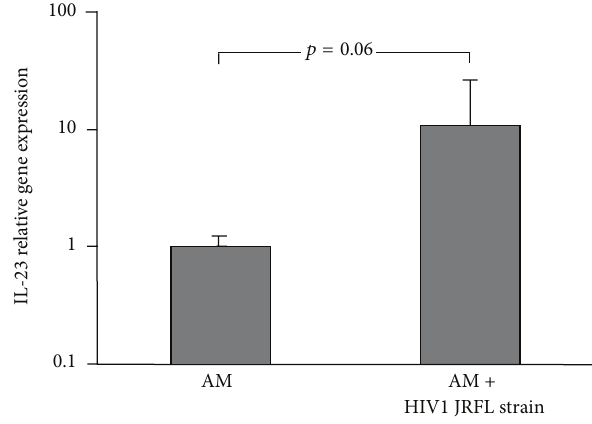
Figure 3: Effect of HIV1 infection in vitro on AM-IL-23 upregu- lation. AM isolated from HIV1 − individuals ( 𝑛 = 5 ) were infected with HIV1 JRFL 10 3 TCID/well or left uninfected. At day 12, RNA was isolated and relative IL-23 expression was assessed by TaqMan PCR (mean ± SEM, 𝑝 = 0.06 , Wilcoxon Signed-Rank